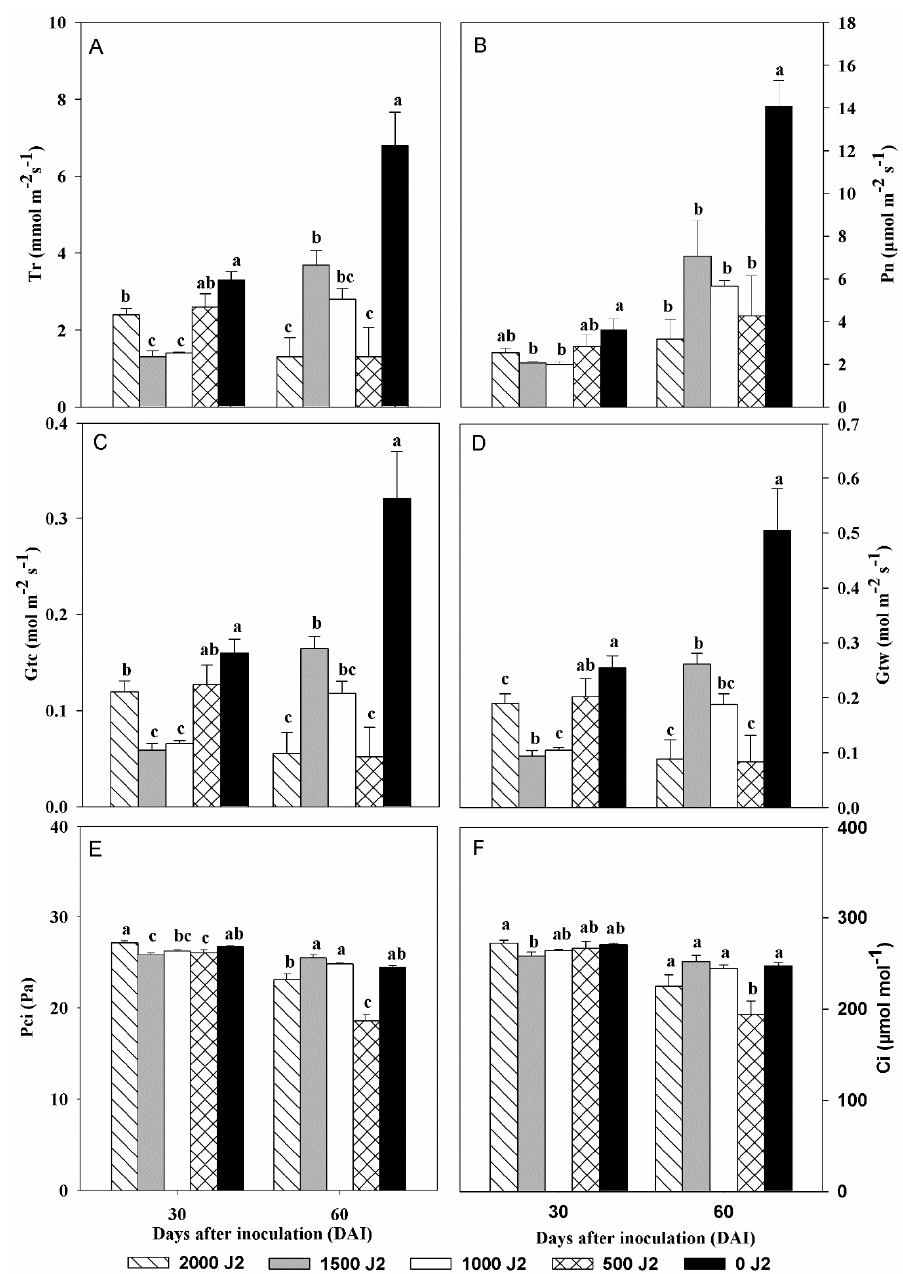
Figure 3. Effects of different inoculum densities of M. graminicola J2 on photosynthetic parameters of rice plant. ( A ): Transpiration rate (Tr); ( B ): net photosynthetic rate (Pn); ( C ): total conductance of CO 2 (Gtc); ( D ): total conductance of water (Gtw); ( E ): partial pressure of intercellular CO 2 (Pci); ( F ): intracellular CO 2 concentration (Ci). Note: The different letters in the same group are significantly different according to LSD at p <